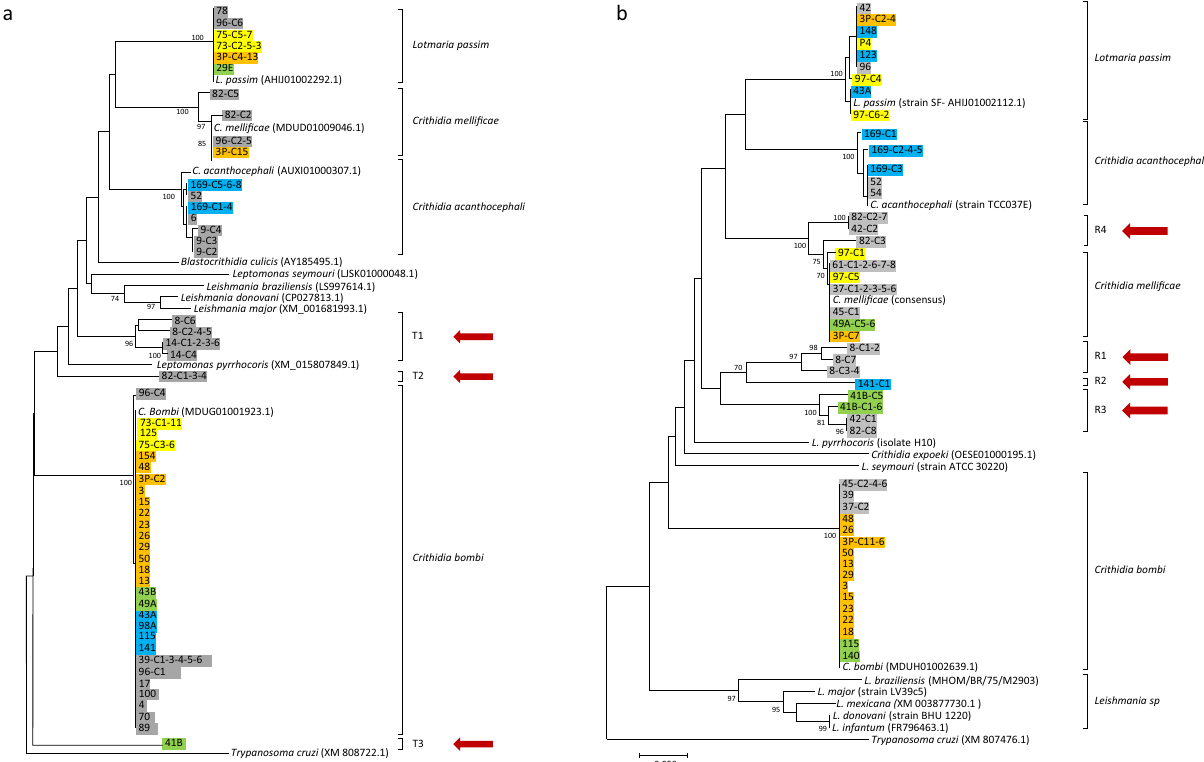
Figure 2. Phylogenetic relationships of the topoII ( a ) and rpb1 ( b ) sequences from Trypanosomatidae. Sequence names include the sample name and the clone number when applicable (C-followed by clone numbers separated by dashes if more than one). Host groups are color-coded: V. velutina (grey), V. crabro (yellow), Bombus spp. (orange), Vespula spp. (blue), Polistes spp. (green). Red arrows indicate new clades. Some sequences that were slightly shorter or with double peaks were excluded. The evolutionary history was inferred using the NJ method. Bootstrap values higher than 70% are shown next to branches. The evolutionary distances were computed using the modified Nei-Gojobori method (assumed transition/transversion bias = 2) and are in the units of the number of synonymous differences per synonymous